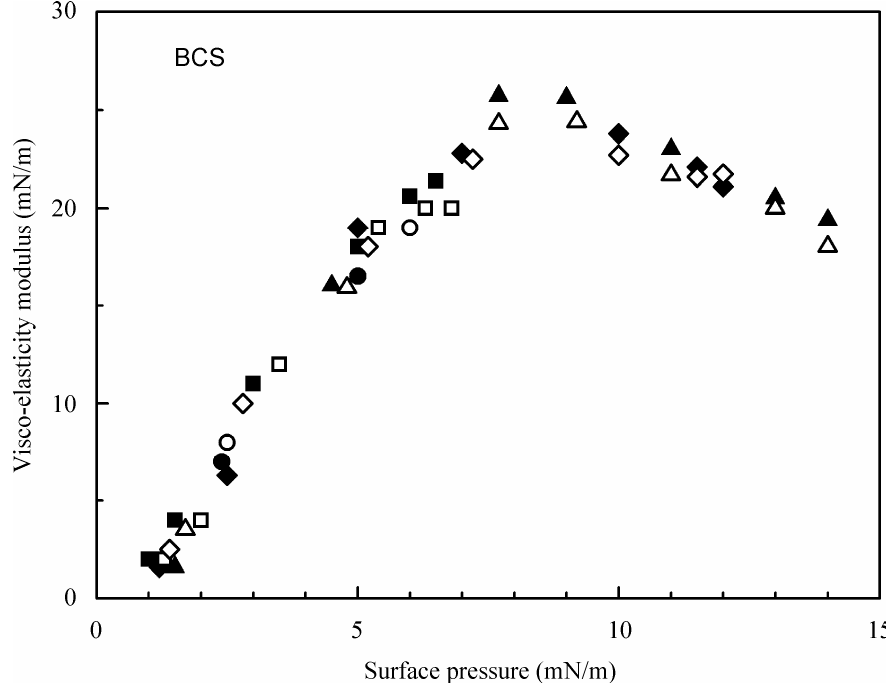
Figure 1. Visco-elasticity modulus of BCS solutions as a function of surface pressure at different adsorption times: , 200 s; , 400 s; , 2000 s; , 5000 s, for the oscillation amplitude 10%. Black points—the results for the amplitude 3%.